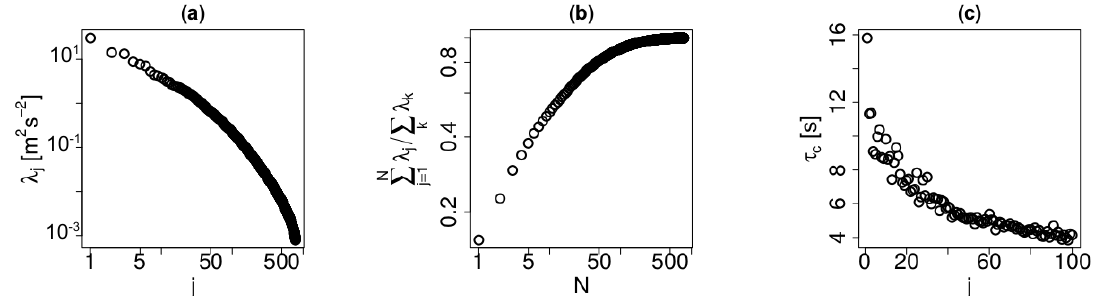
Figure 6. ( a ) POD eigenvalues; ( b ) Normalised cumulative spectrum of the POD representing the percentage of captured turbulent kinetic energy; ( c ) Integral time scale of the weighting coefficients versus mode number.